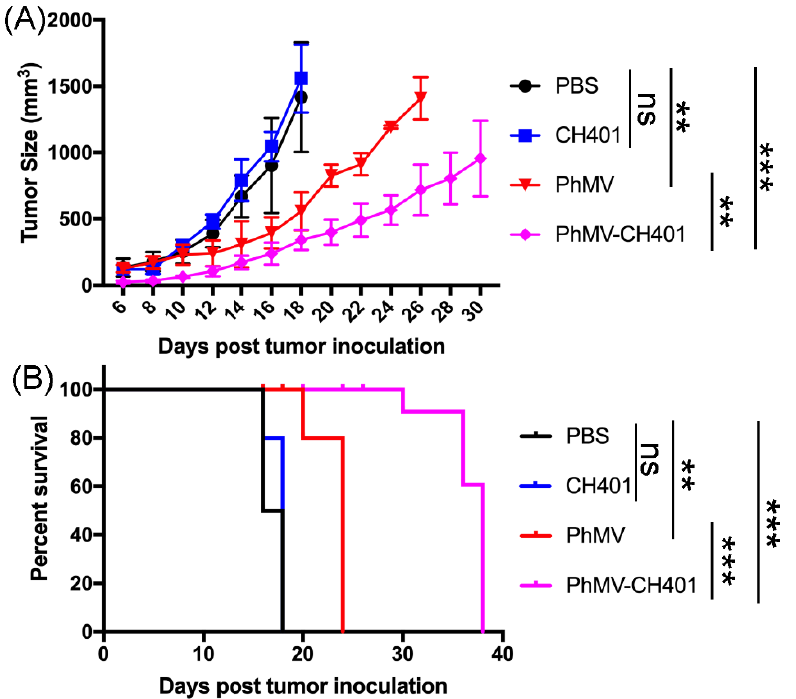
Figure 4. PhMV-based vaccine anti-tumor efficacy in DDHER2 murine model. ( A ) Mean tumor size of mice per treatment group ( n = 5), statistical analysis was carried out by two-way ANOVA. Mean tumor volumes and standard errors of the mean are shown. ( B ) Statistical analysis of survival curves: log-rank (Mantel – Cox) test. ns = no statistical significance, ** p < 0.01; *** p < 0.001. (The treatment schedule is shown in Figure 2).